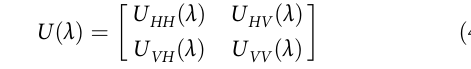
Fig. 4 Polarization control of the engineered state at an arbitrary delay time τ τ ¼ 8 : 5 ps. a Enhancing only the H component of the s . We choose here s output fi eld. b Enhancing only the V component of the output fi eld. c Attenuating only the H component of the output fi eld. d Attenuating only the V component of the output fi eld. Inset: reconstructed intensity at the output at delay time τ s for both H and V. Color code: (red) total impulse response of H and V; (black) impulse response of the H component; (orange) impulse response of the V component; (blue) time of fl ight distribution of H and